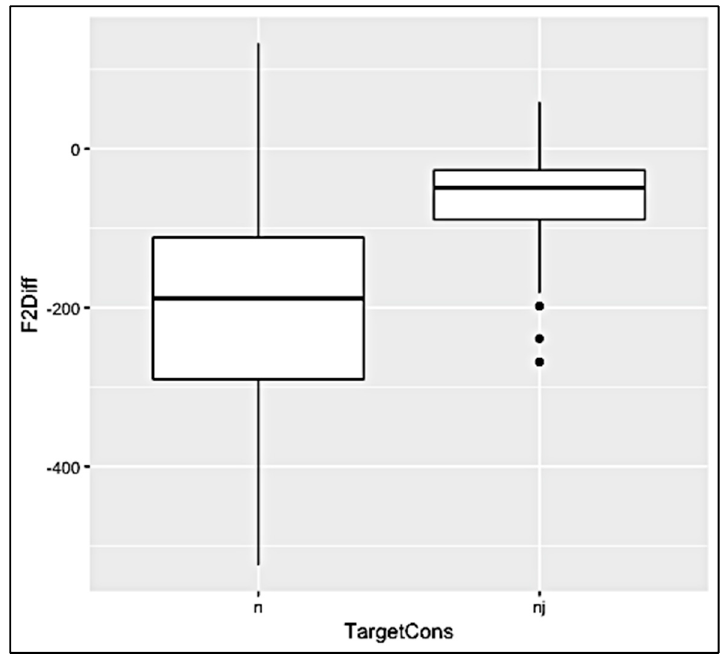
Figure 3. Plot of F2Diff (in Hz) by Auditory Code (n, nj) in all speakers. N =